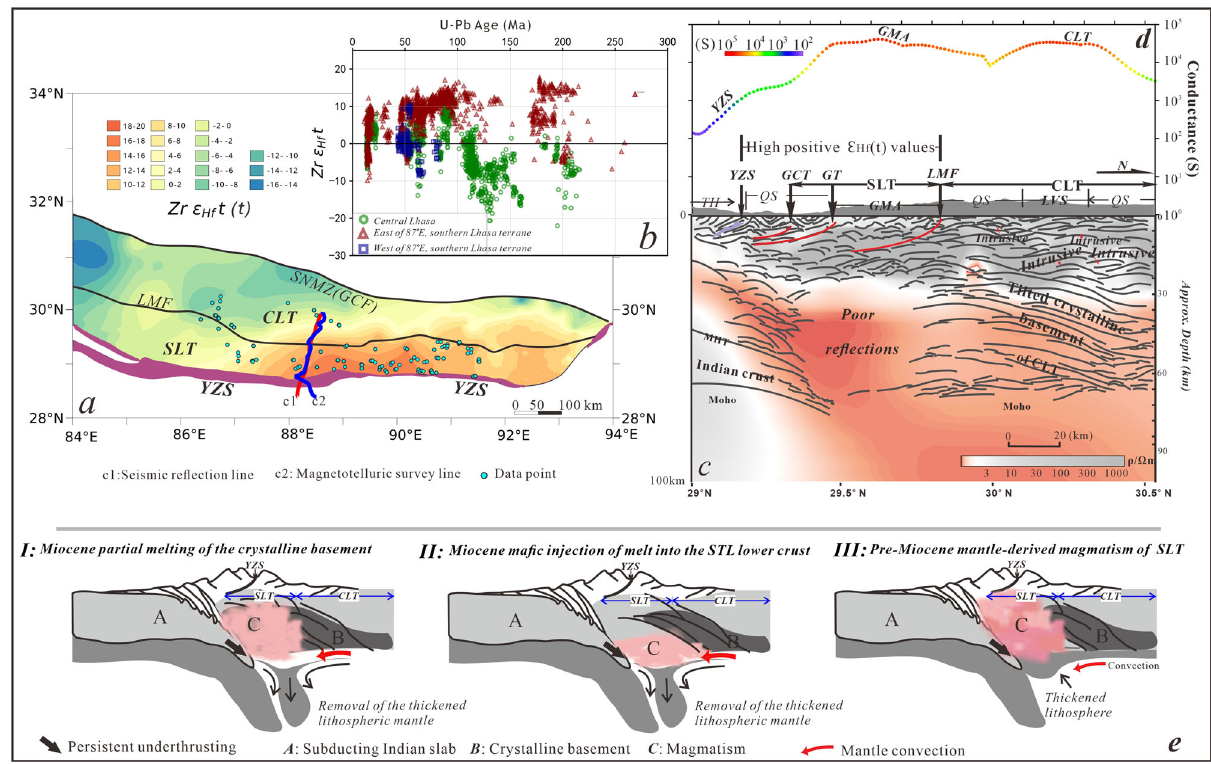
Fig. 3 Integrated analysis. a Hf isotope contour map of the southern and central Lhasa terranes between of 84 ˚ E and 94 ˚ E showing the regional distribution of zircon ε Hf (t) values as measured from Mesozoic-Cenozoic granitoids and felsic volcanic rocks. b Inset fi gure represents plots of zircon ε Hf (t) values versus U-Pb age of zircons from felsic rocks. (Supplementary Dataset S2 lists literature sources for these values). c Comparison of the deep seismic re fl ection structures and the electrical structure by 27 (see Fig. 3a for survey line location). d The electrical conductance values (in siemens (S)) calculated at depths ranging between 30 – 60 km by studies of Xue et al. 28 . e Three hypotheses proposed accounting for lateral heterogeneity in crustal- scale seismic-re fl ectivity patterns beneath the Lhasa terrane and the third style is the preferred model. See abbreviations in Fig.